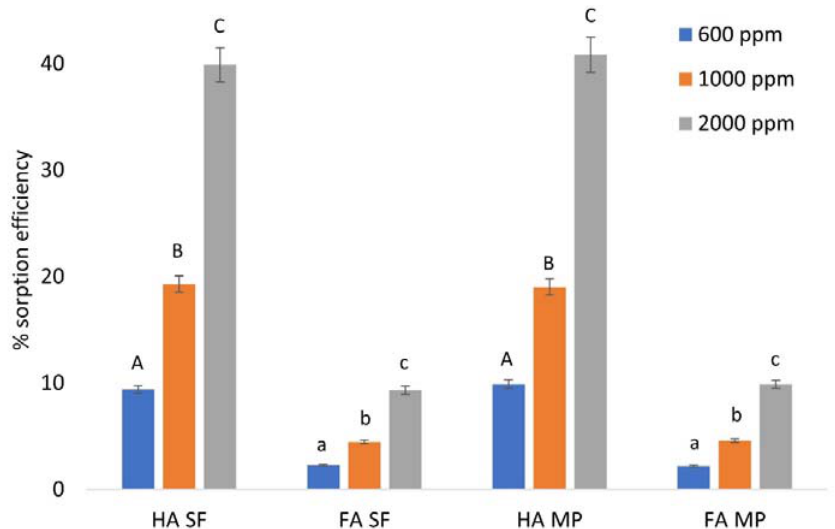
Figure 6. % Sorption efficiency of azoxystrobin using humic acid (HA) or fulvic acid (FA) extracted from different concentrations of lignite from South Field (SF) or Mavropigi (MP) mines; bars represent the average sorption efficiency of five replicate analyses; statistically significant differences ( p < 0.05) are depicted with small and capital letters.